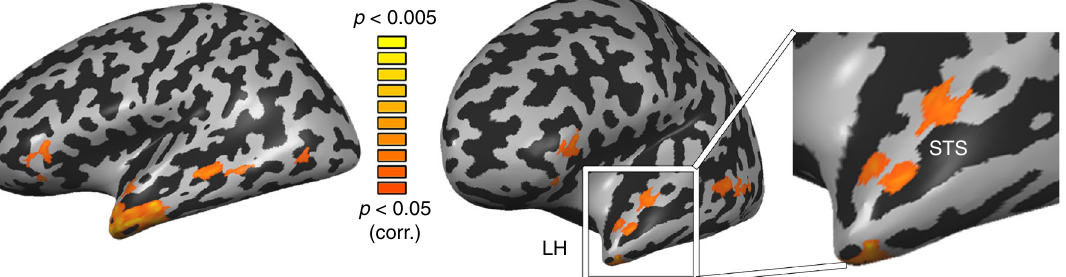
Table 1 Blind subjects characteristics